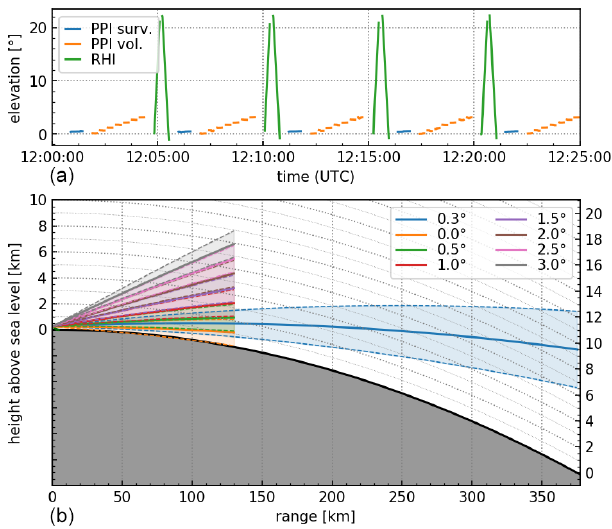
Figure 5. (a) Sample of temporal sequence of long-range surveil- lance PPI (blue), short-range volume PPI (orange), and short-range RHI towards BCO (green). (b) Beam propagation relative to sea sur- face for long-range (blue) and short-range PPIs. Shaded area repre- sents 1 ◦